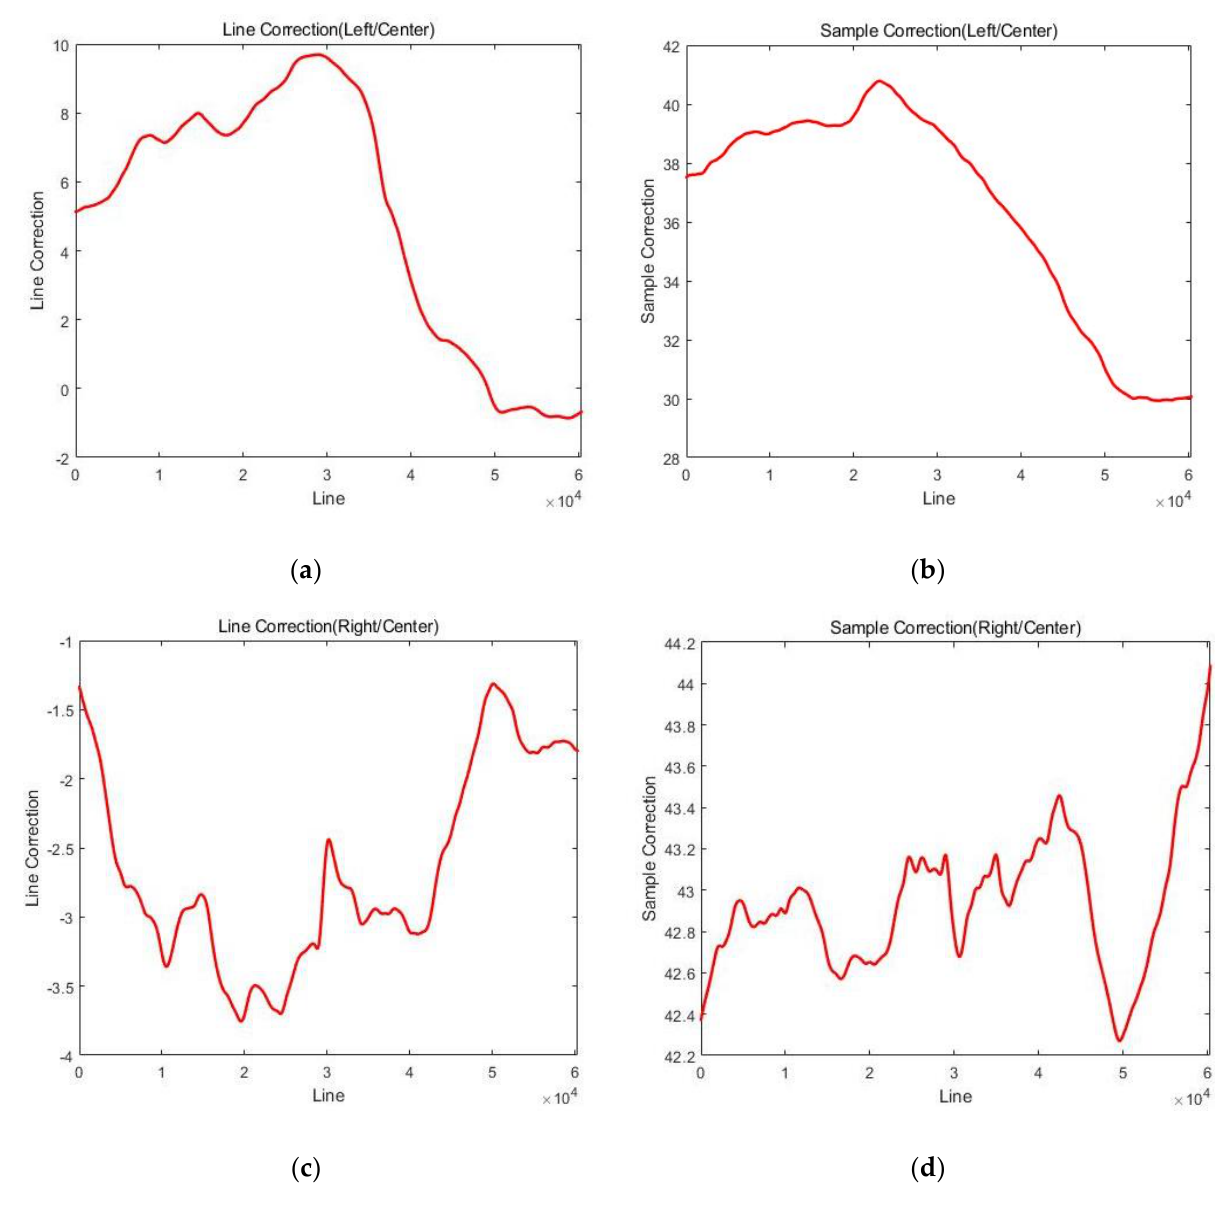
Figure 9. Estimated discrepancy compensation — ( a ) line compensation for Strip #1; ( b ) sample compensation for Strip #1; ( c ) line compensation for Strip #3; ( d ) compensation for Strip #3.